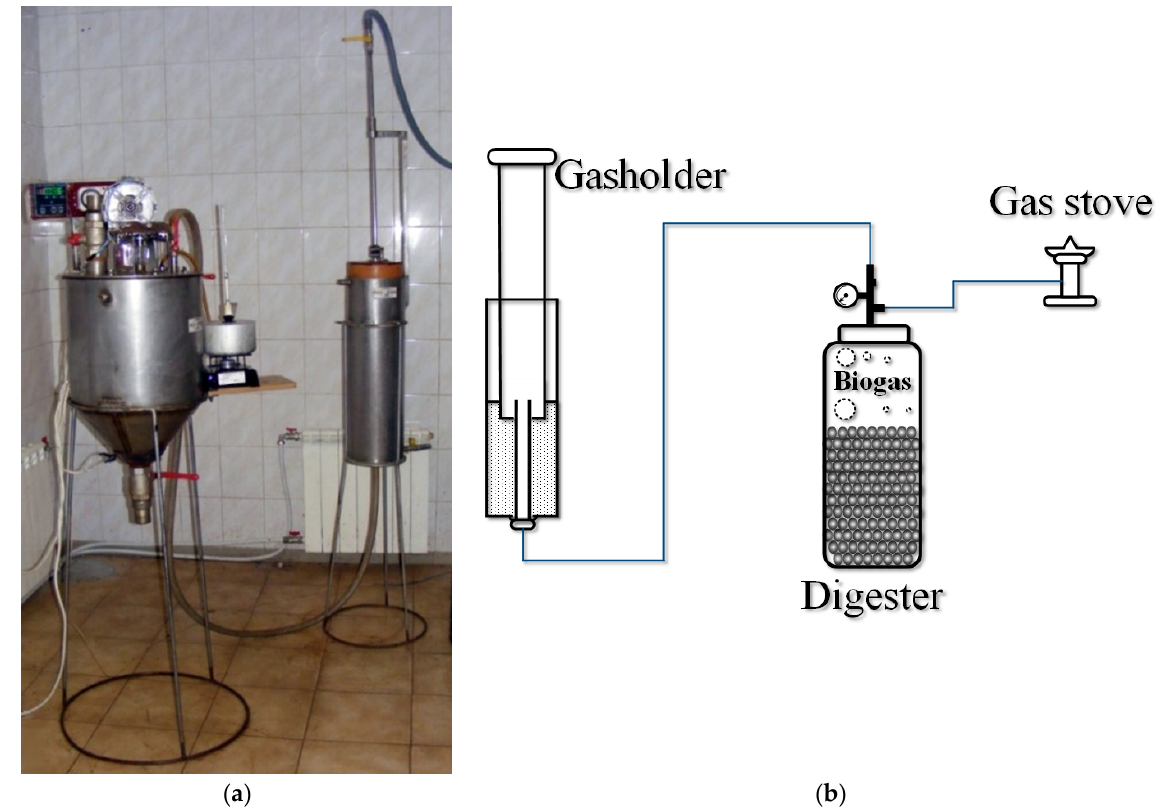
Figure 1. Lab-scale biogas plant: ( a ) general view and ( b ) principal scheme.